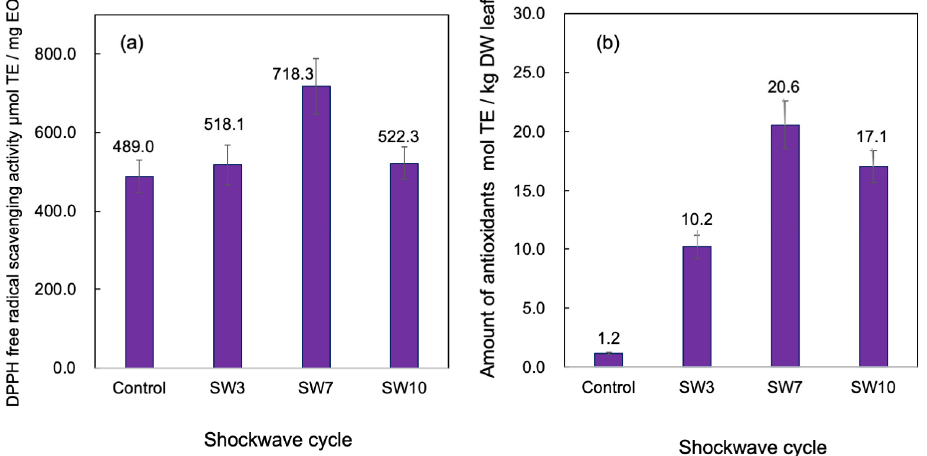
Figure 3. ( a ) DPPH free radical scavenging activity of essential oils and ( b ) the amount of antioxidants in essential oils obtained by steam distillation from A. sachalinensis dried leaves. Bars represent the mean ± standard deviation of three independent experiments. The number of SW indicates the number of additional cycles of the shockwave at 3.0 kV and 3.6 kJ.